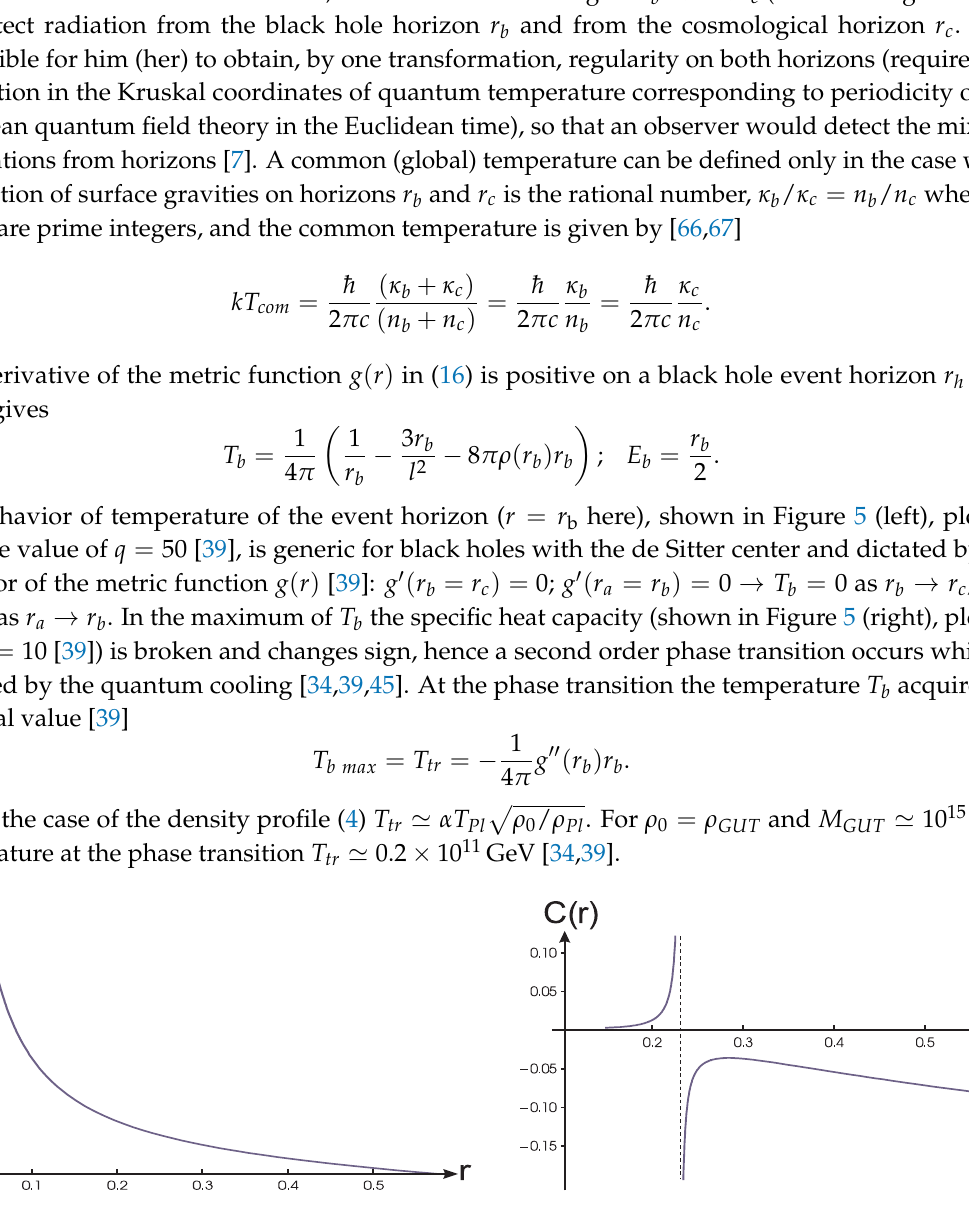
Figure 5. Generic behavior of temperature ( left ) and specific heat ( right ) of a regular cosmological black